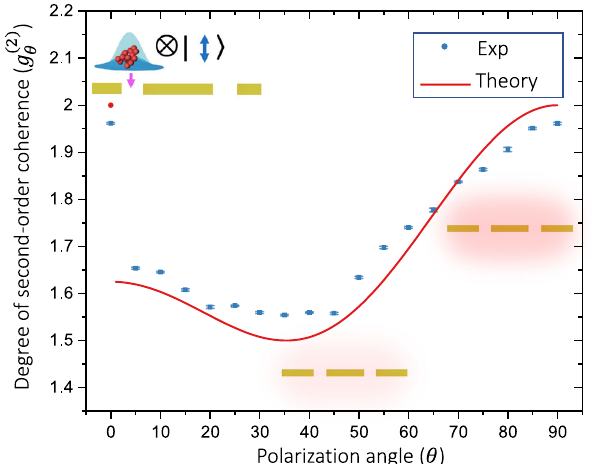
Fig. 3 Modi fi cation of the quantum statistics of a single multiparticle system in a plasmonic structure. The experimental data is plotted together with the theoretical prediction for the degree of the second-order correlation function. The theoretical model is based on the photon-number distribution described by Eq. (2) for a situation in which (cid:1) n s ¼ 3 (cid:1) n Pl. The error bars represent the standard deviation of ten realizations of the experiment. Each experiment consists of ~100,000 photon-number- resolving